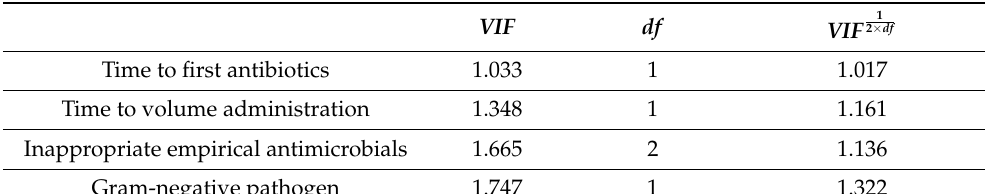
Table 3. Variance inflation factor ( VIF ), degrees of freedom ( df ) and VIF multivariable model.